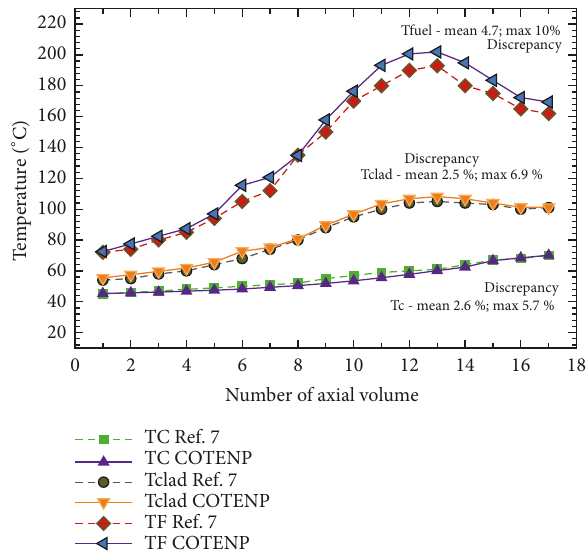
Figure 9: Comparison of the temperature distribution in the hot channel of the CARR reactor between the COTENP code and reported results [7]. TF is the centerline temperature, Tclad is the cladding temperature, and TC is the coolant temperature.